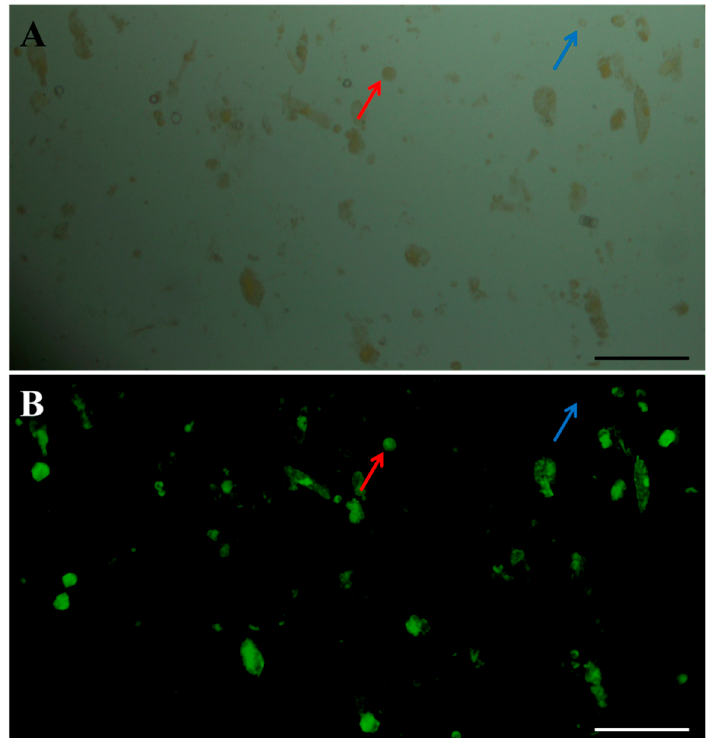
Figure 6. Viability of protoplasts isolated from Chinese kale hypocotyls: ( A ) Fluorescein diacetate (FDA)-dyed protoplasts under bright light and ( B ) FDA-dyed protoplasts under ultraviolet light. Scale bars = 100 μ m. Red arrows represent viable protoplasts and blue arrows represent non-viable protoplasts.